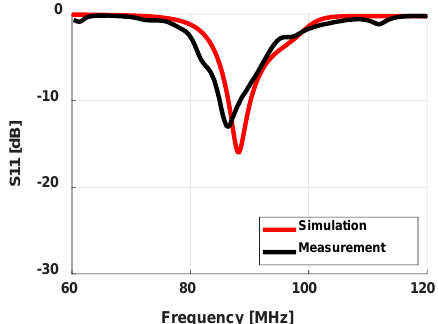
Figure 10. Comparison of measured and simulated reflection coefficients of the fabricated proto- type.